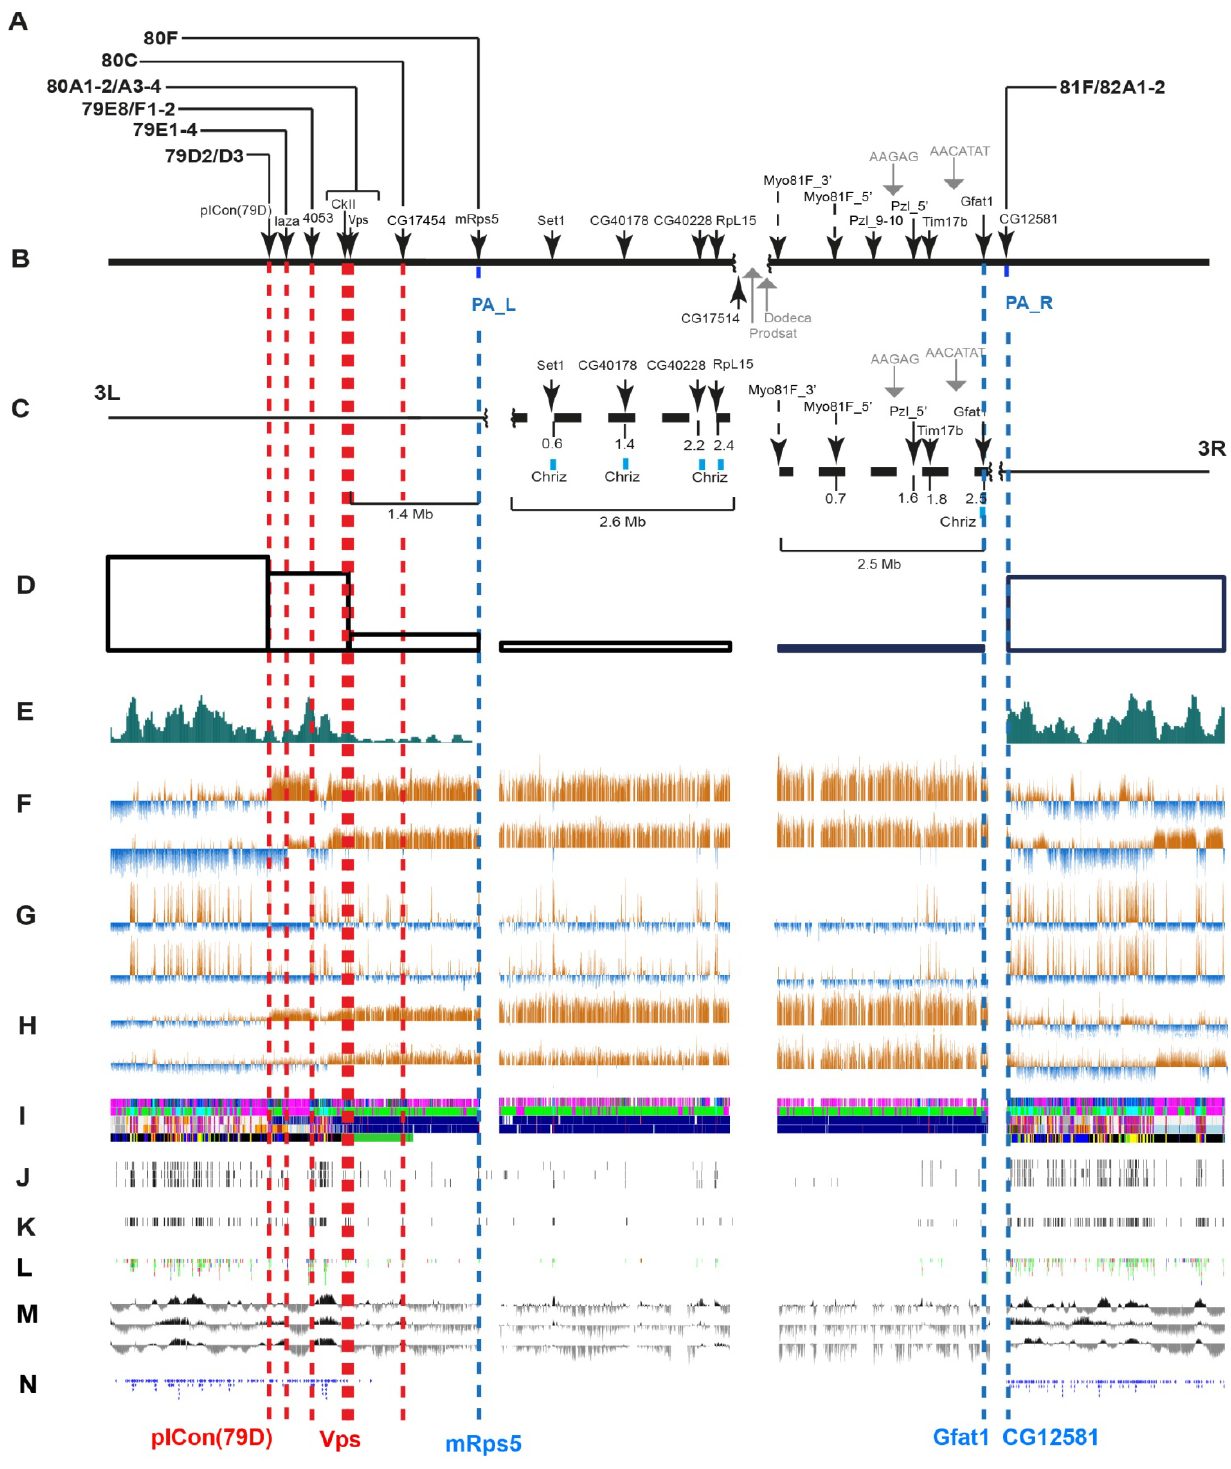
Figure 4. Molecular and genetic organization of pericentromeric heterochromatin in arms 3L and 3R of D. melanogaster (FlyBase release 5). The newly polytenized regions of chromosome 3 heterochromatin are located between PA_L and PA_R (blue vertical dashed lines). ( A ) Cytological locations of bands and FISH probes with figures and letters as on the chromosome map. ( B , C ) Localization of DNA probes from unique genes (black arrows) on the physical map; gray arrows point to the sites of satellite DNA. Map distances between the genes are expressed in megabases of nucleotides. ( D , E ) Gene density in euchromatin and heterochromatin according to our ( D ) and previous [73] calculations ( E ). ( F ) Localization of histone modification H3K9me2 in the S2 (upper line) and BG3 (lower line) cell cultures (modENCODE data [46]). ( G ) Localization of the CHRIZ protein in the S2 (upper line) and BG3 cell cultures (lower line) (modENCODE data). ( H ) Lo- calization of the HP1 protein in the S2 (upper line) and BG3 cell cultures (lower line) (modENCODE data). ( I ) Chromatin